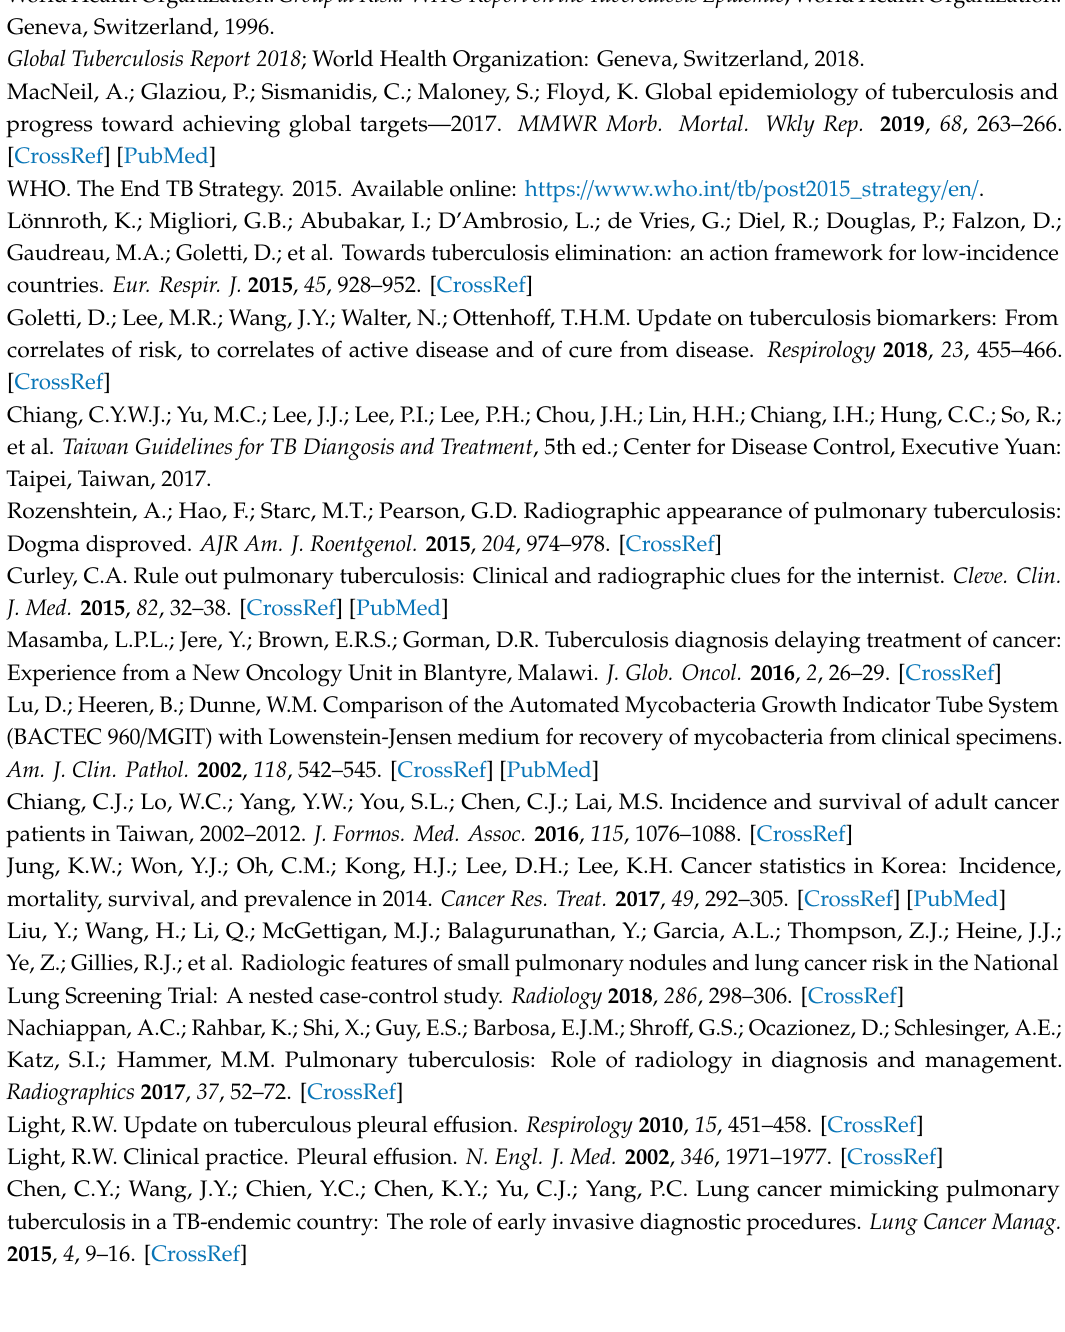
Table S1: The demographics of patients according to the timing to obtain pathology